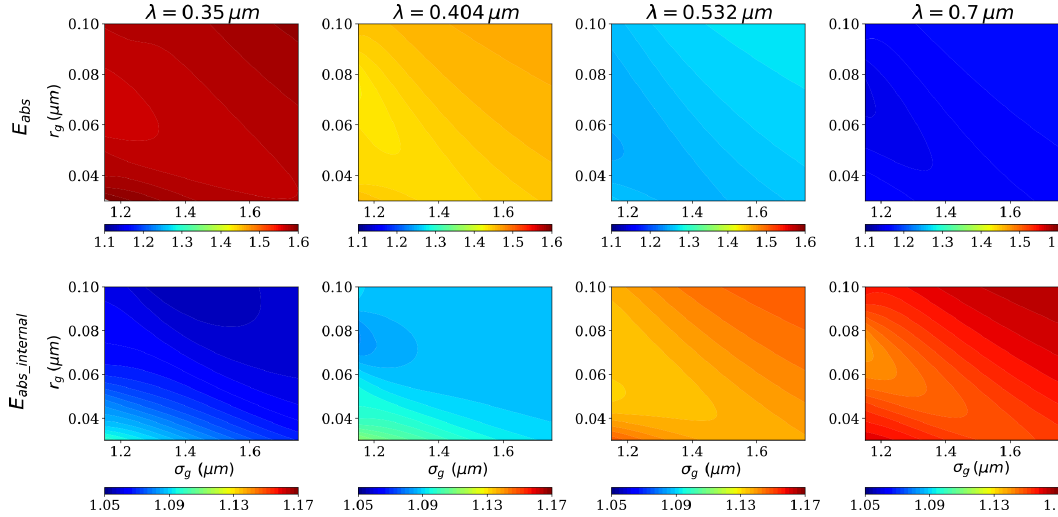
Figure 4. E abs and E abs_internal of thinly coated BC with BrC coatings at different size distributions ( D f = 2 . 2, f BC = 40%).